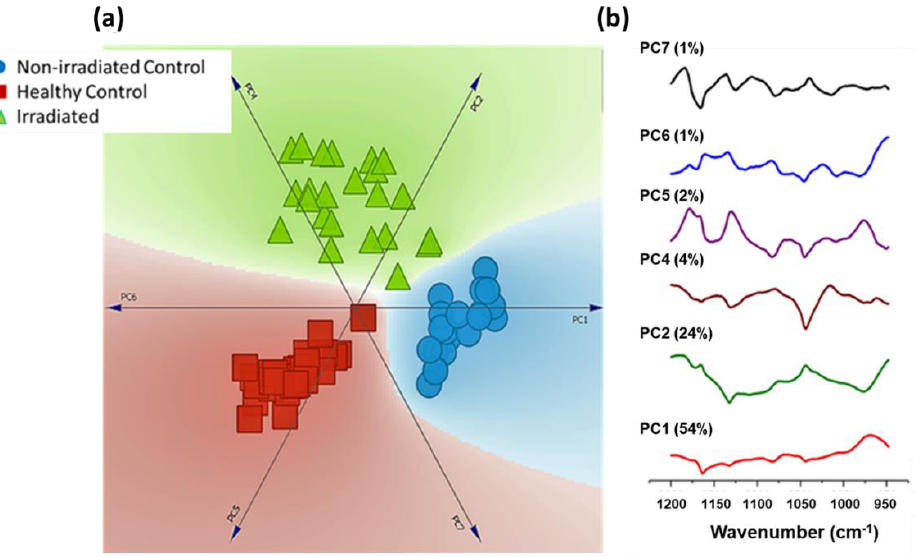
Figure 4. ( a ) Linear projection plot of principal components used for spectral discrimination. ( b ) Loading plot of principal component used for PCA. Variance contribution of each principal component is shown in the parenthesis.